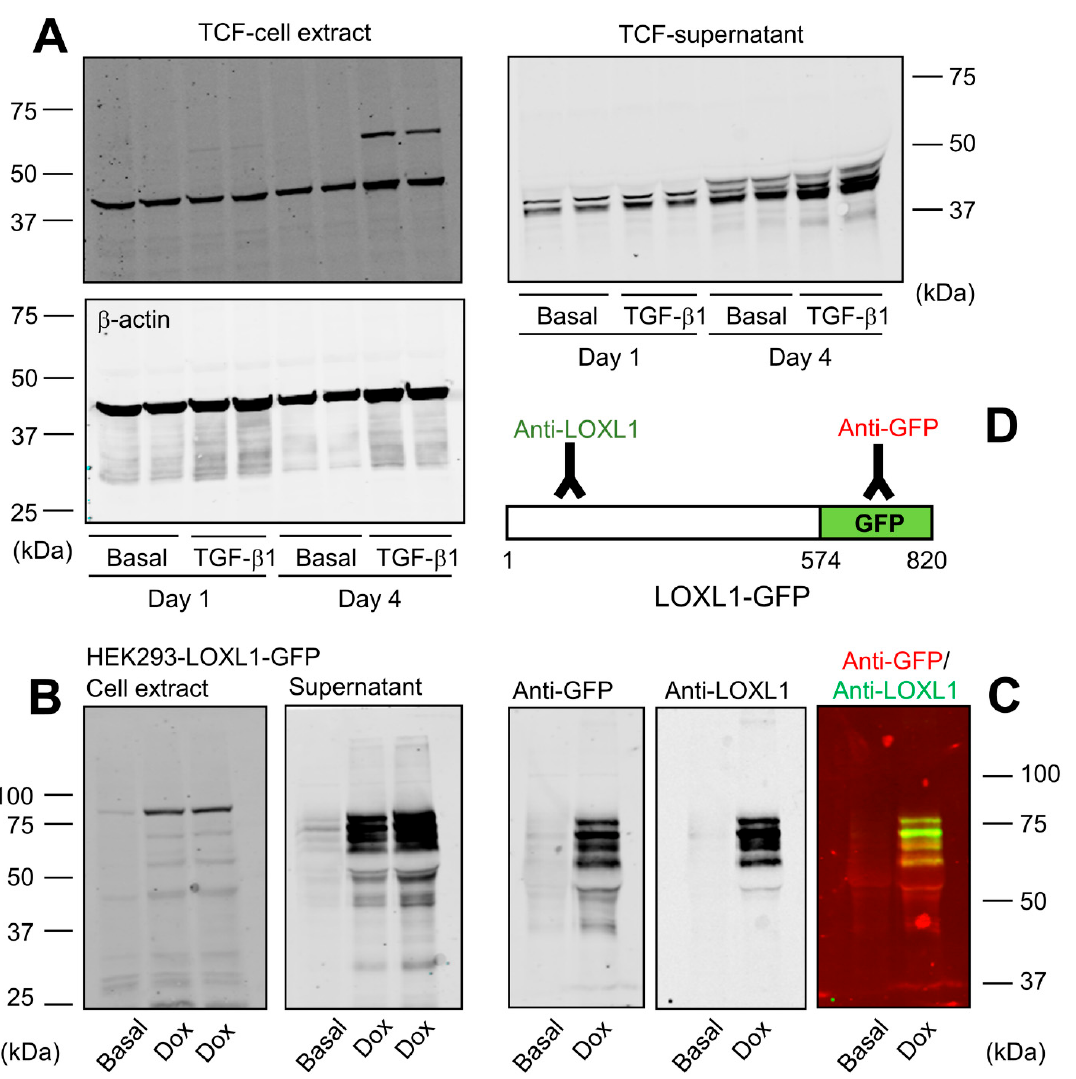
Figure 1. LOXL1 protein is expressed in multiple forms. ( A ) Human Tenon’s capsule fibroblasts (TCF) were incubated for 1 or 4 days under basal conditions or in the presence of 5 ng/mL of TGF- β 1. Cell extracts and supernatants were taken and processed for Western blotting with a specific LOXL1 antibody recognizing the N-terminal region. Housekeeping β -actin protein was also probed in cell extracts as indicated for normalization purposes. ( B ) Generation of HEK293 cells over-expressing human LOXL1-GFP fusion protein in a tetracycline-inducible manner. LOXL1 protein in the cell extract and supernatant fractions was analyzed under basal conditions and upon a 48-hour induction with the tetracycline analogue, doxycycline (Dox), using an anti-GFP antibody. Analysis of cell extracts revealed intracellular bands close to the theoretical molecular weight of 60 kDa for LOXL1 from TCF and 90 kDa for LOXL1-GFP in HEK293 cells. A band of about 40 kDa recognized in TCF extracts by the LOXL1 antibody presumably represents a non-specific product. The supernatant of TCF and HEK293 cells revealed the presence of multiple forms of LOXL1 (35 − 50 kDa) and LOXL1-GFP (40 − 75 kDa), respectively, with TCF likely also showing non-specific band/s. ( C ) Simultaneous detection of LOXL1-GFP protein with anti-GFP and anti-LOXL1 antibodies showing both signals separately and together (red, GFP; green, LOXL1). ( D ) Schematic representation of the recognition regions of LOXL1-GFP by anti-LOXL1 and anti-GFP antibodies. The blots shown correspond to representative experiments performed twice with two independent preparations.